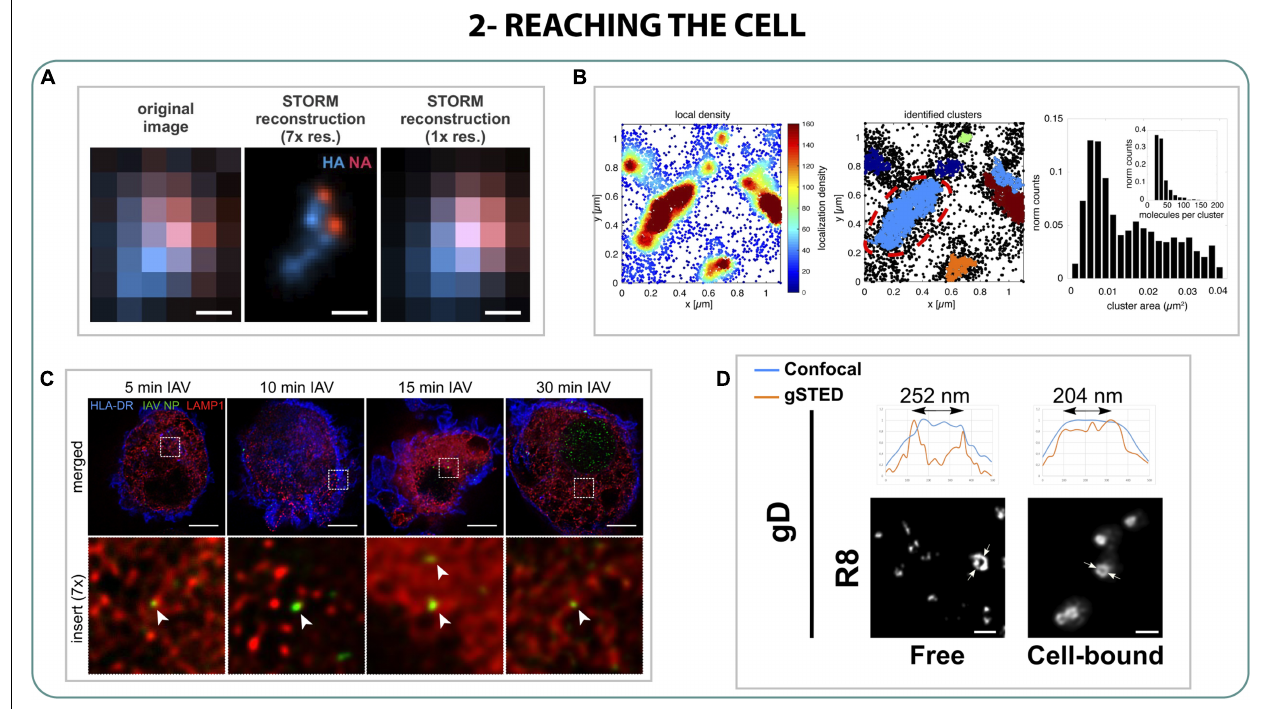
FIGURE 3 | Reaching the cell. (A) 2-color STORM of HA (blue) and NA (red) on influenza filamentous virions. Scale bar 200 nm (Vahey and Fletcher, 2019). (B) STORM density-based localization analysis of small sialic acid clusters on cells (Sieben et al., 2020). (C) STED studies of IAV (green) trafficking through late endosomes (red) in dendritic cells from 5 to 30 min post exposure. Scale bar: 5 µ m (Baharom et al., 2017). (D) STED images of herpesvirus glycoprotein gD in free or cell-bounded virions. Scale bar 500 nm (Beilstein et al.,